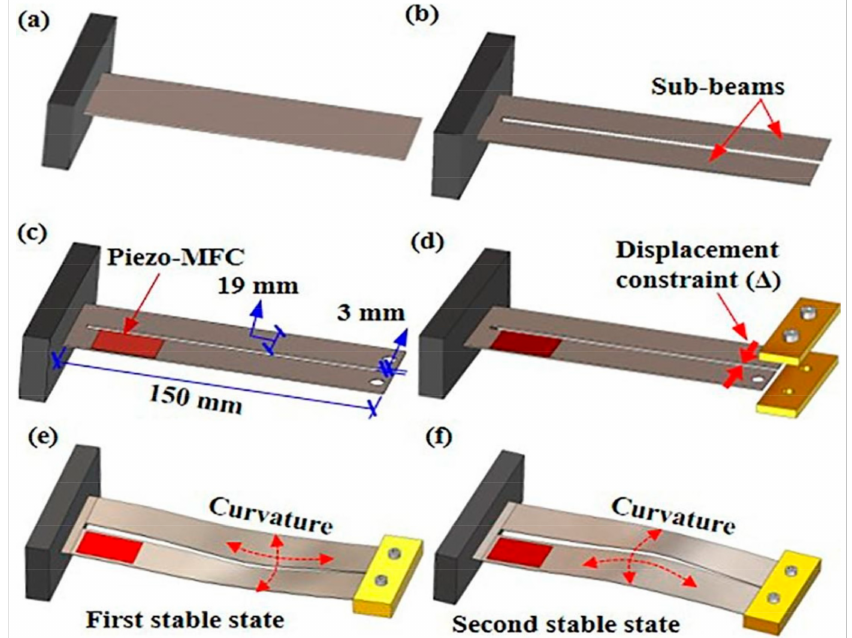
Figure 18. Design of the proposed bio-inspired bi-stable piezoelectric energy harvester: ( a ) cantilever beam, ( b ) tailored cantilever beam with two sub-beams, ( c ) the piezoelectric transducer was attached to one of the sub-beams to harvest vibration energy, ( d ) applied in-plane displacement constraint, ( e ) bi-curved sub-beams under the applied constraint (first stable state), and ( f ) the second stable state [157].